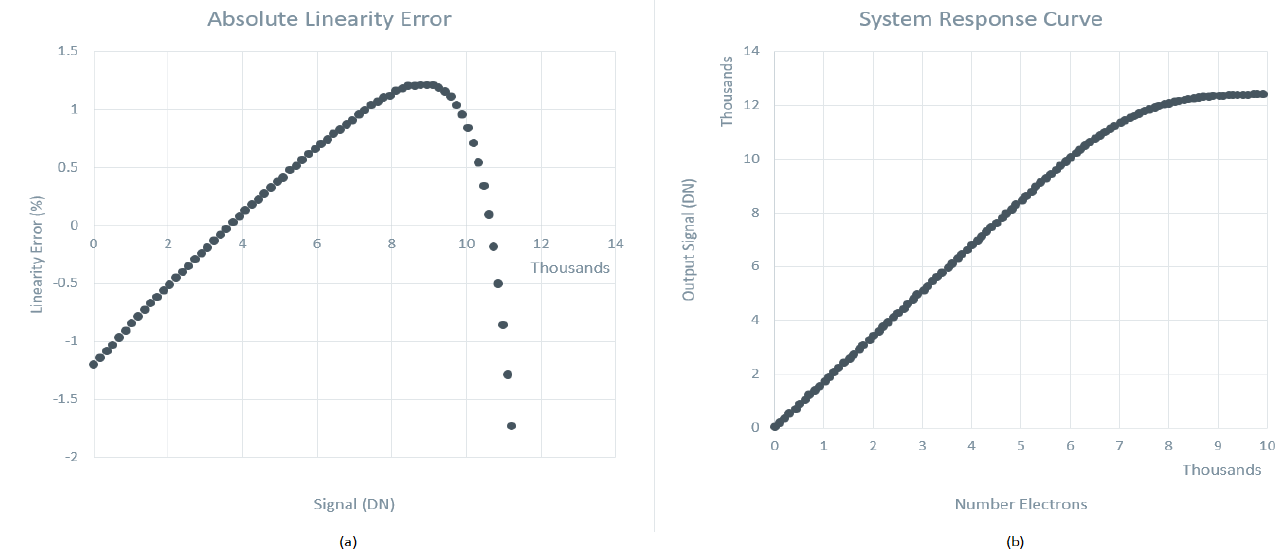
Figure 17. Full readout circuit input-to-output response. ( a )—Absolute linearity error from enhanced readout; ( b )—Equivalent system response from the enhanced readout circuits’ chain.